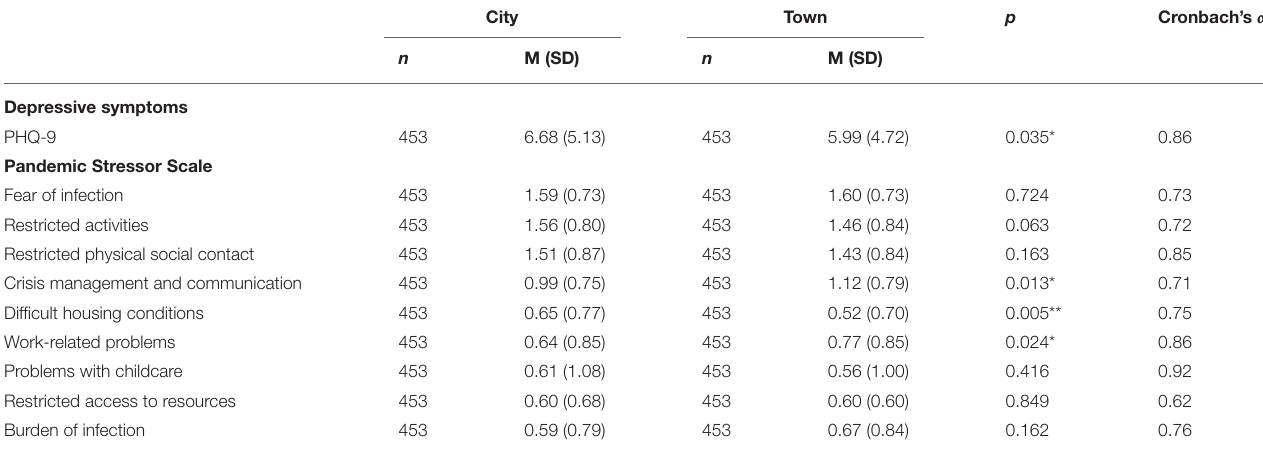
TABLE 2 | Depressive symptoms measured by the PHQ-9 and stressors measured by the Pandemic Stressor Scale after propensity score matching. City Town p Cronbach’s α n M (SD) n M